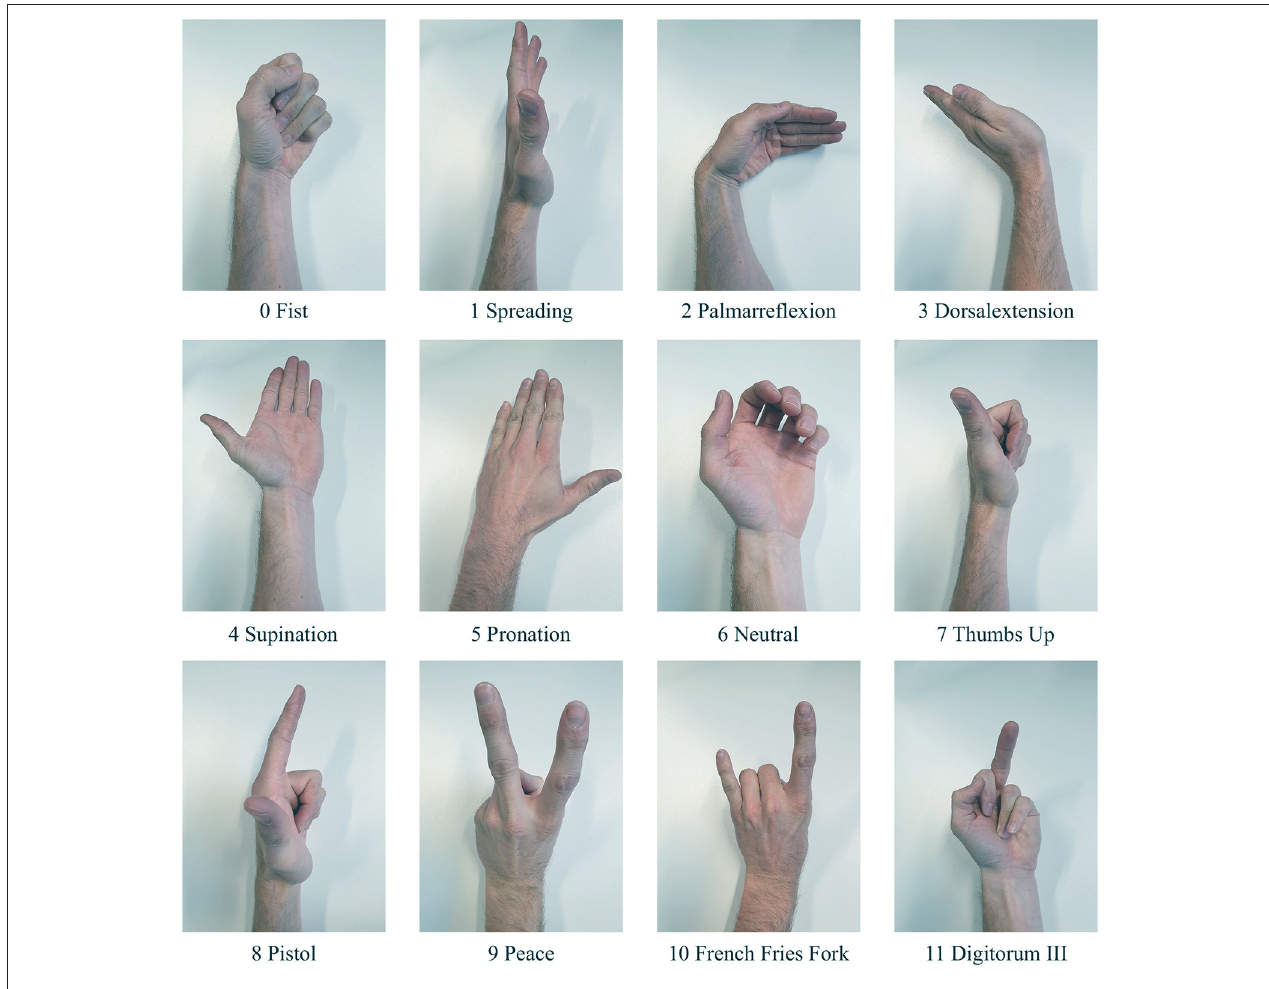
FIGURE 3 | The used gesture set for the experimental setup of the study.